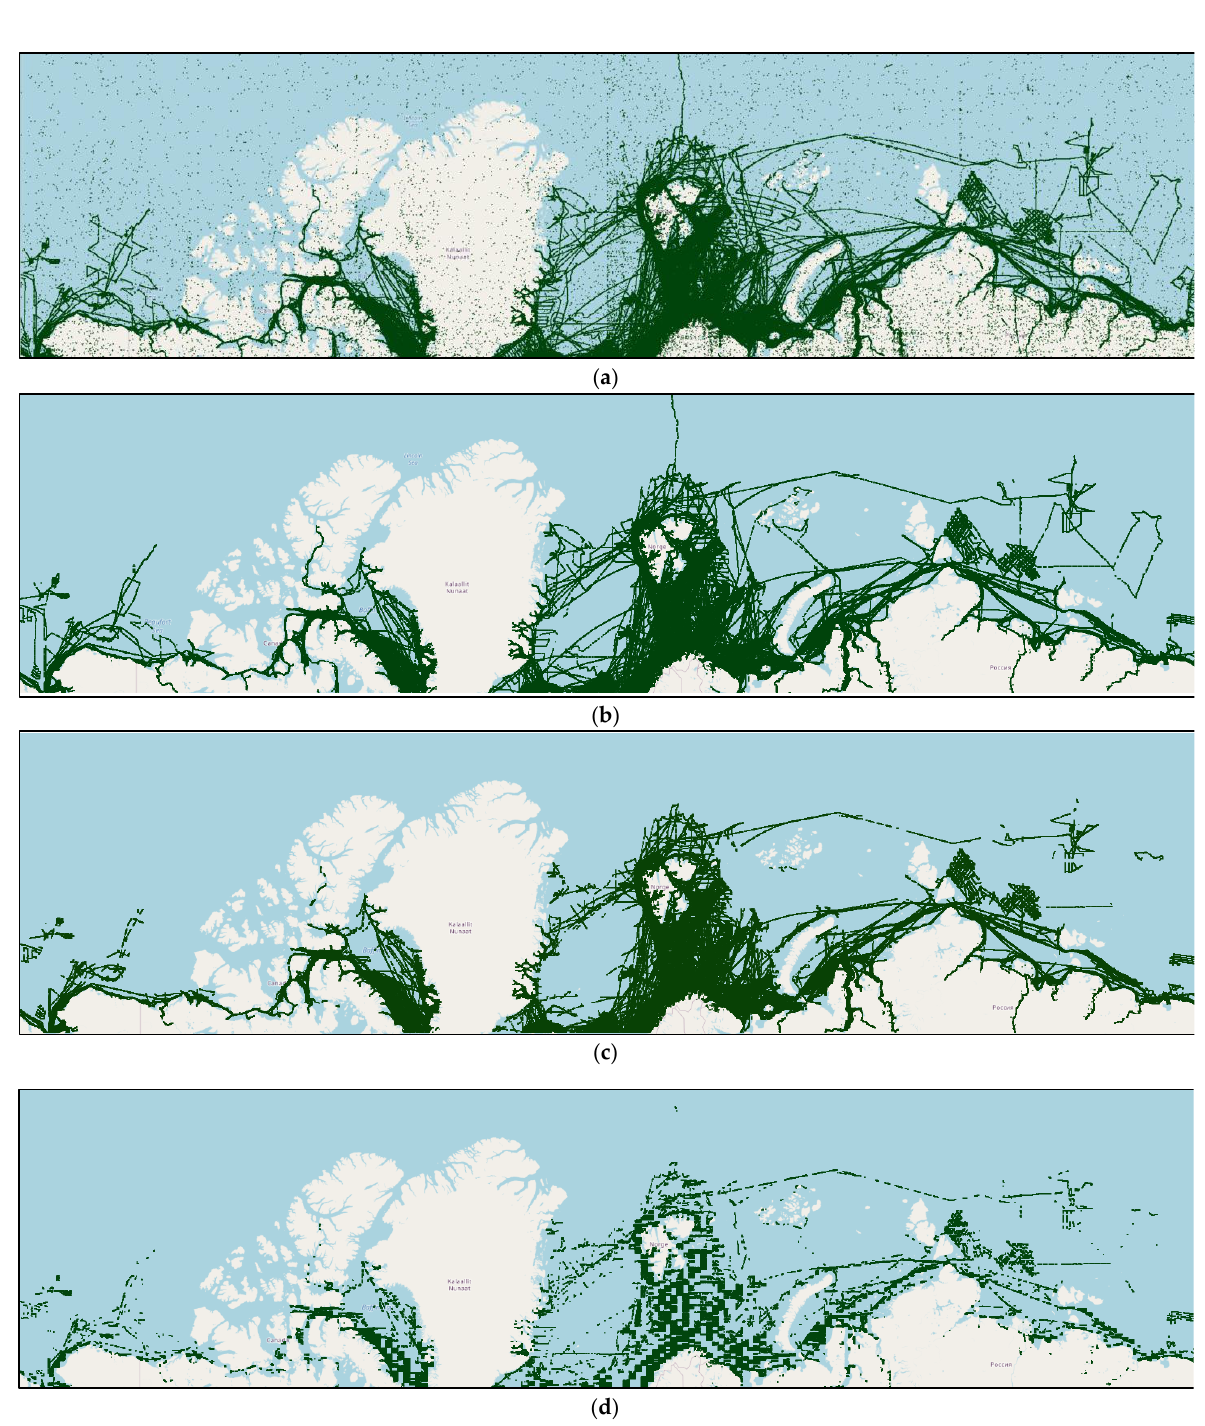
Figure 6. Visualisation of different kernel functions in the Arctic Ocean. ( a ) The original data; ( b ) the results with Gaussian convolution kernel; ( c ) the results with mean convolution kernel; ( d ) the results with sharpening convolution kernel.